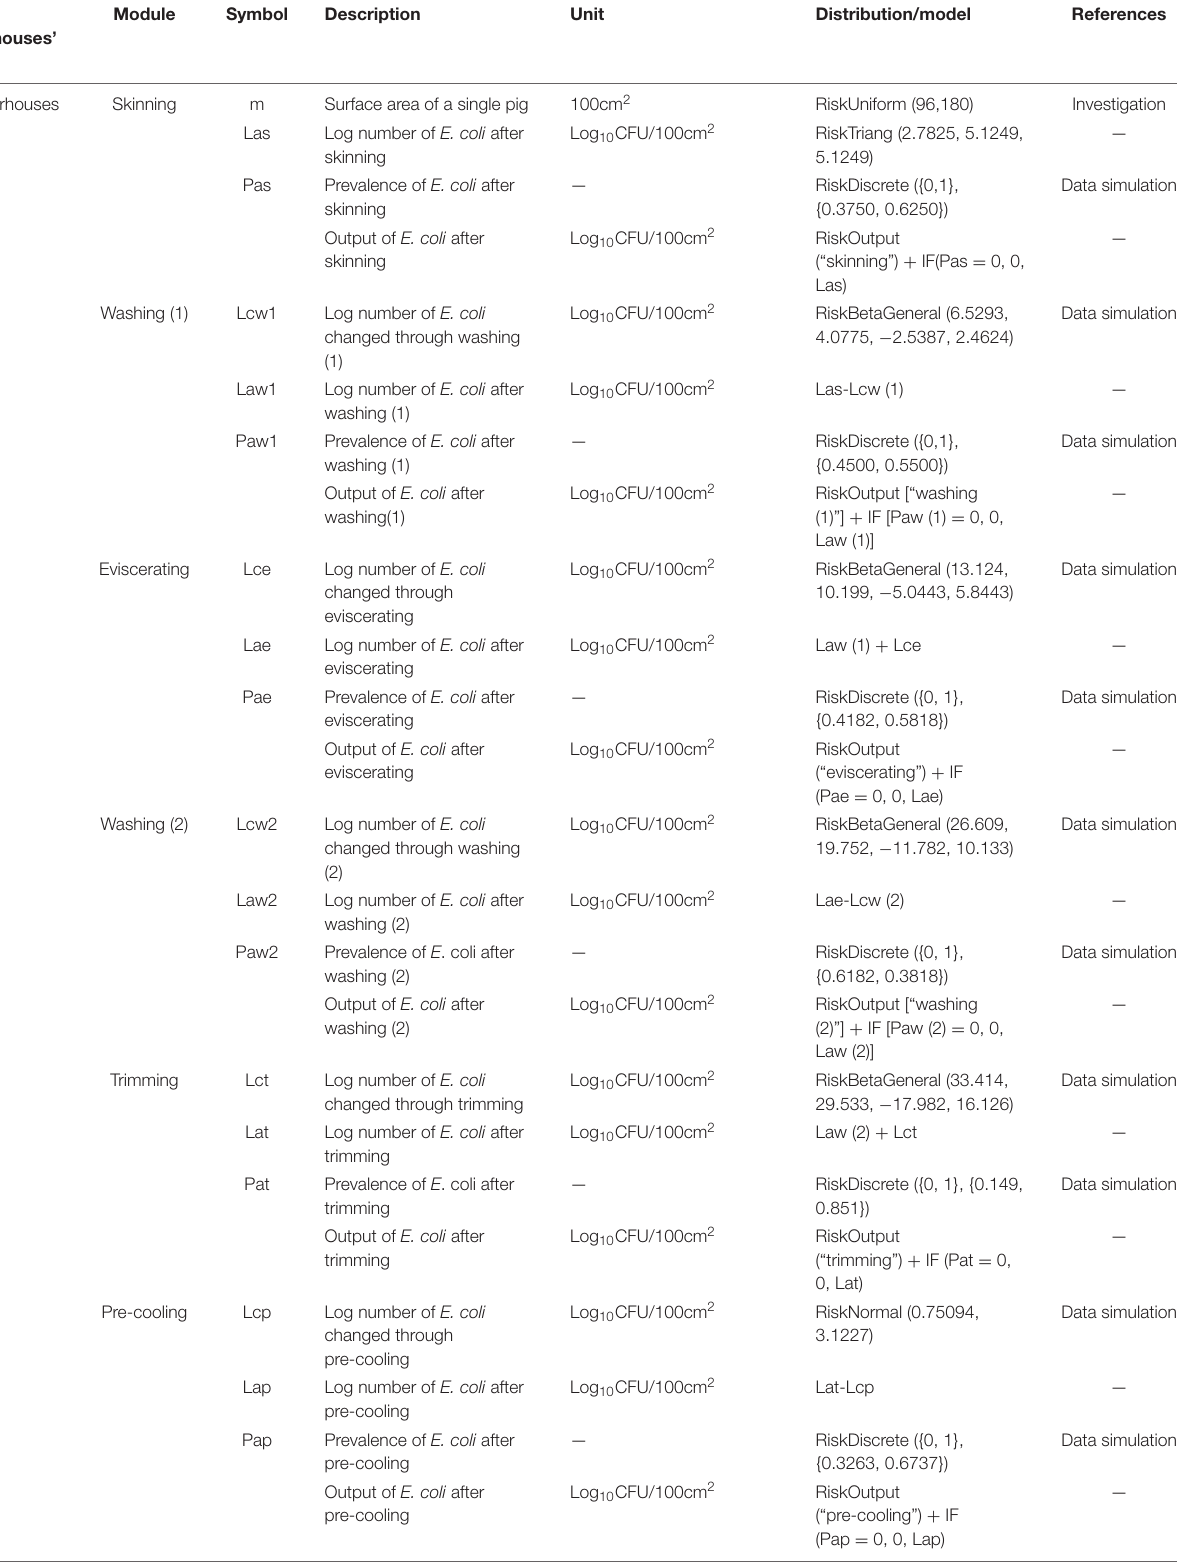
TABLE 1 | Escherichia coli exposure assessment model of swine-slaughtering